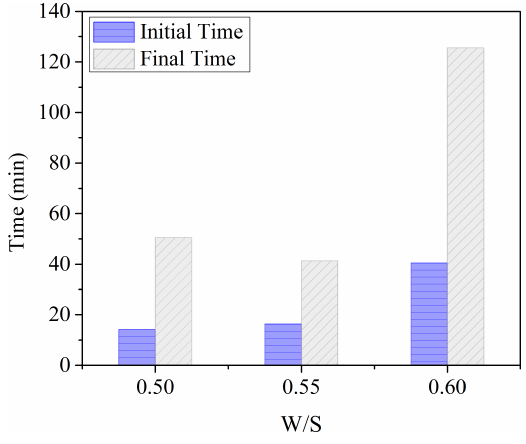
Figure 11: Effect of different Nano-SiO 2 content on compressive